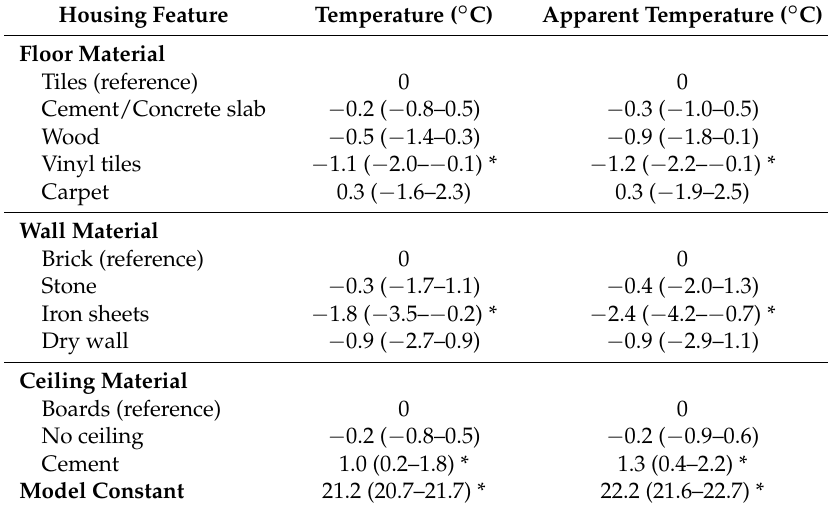
Table 5. Coefficients (95% CIs) from the multilevel linear regression of temperature and apparent temperature.